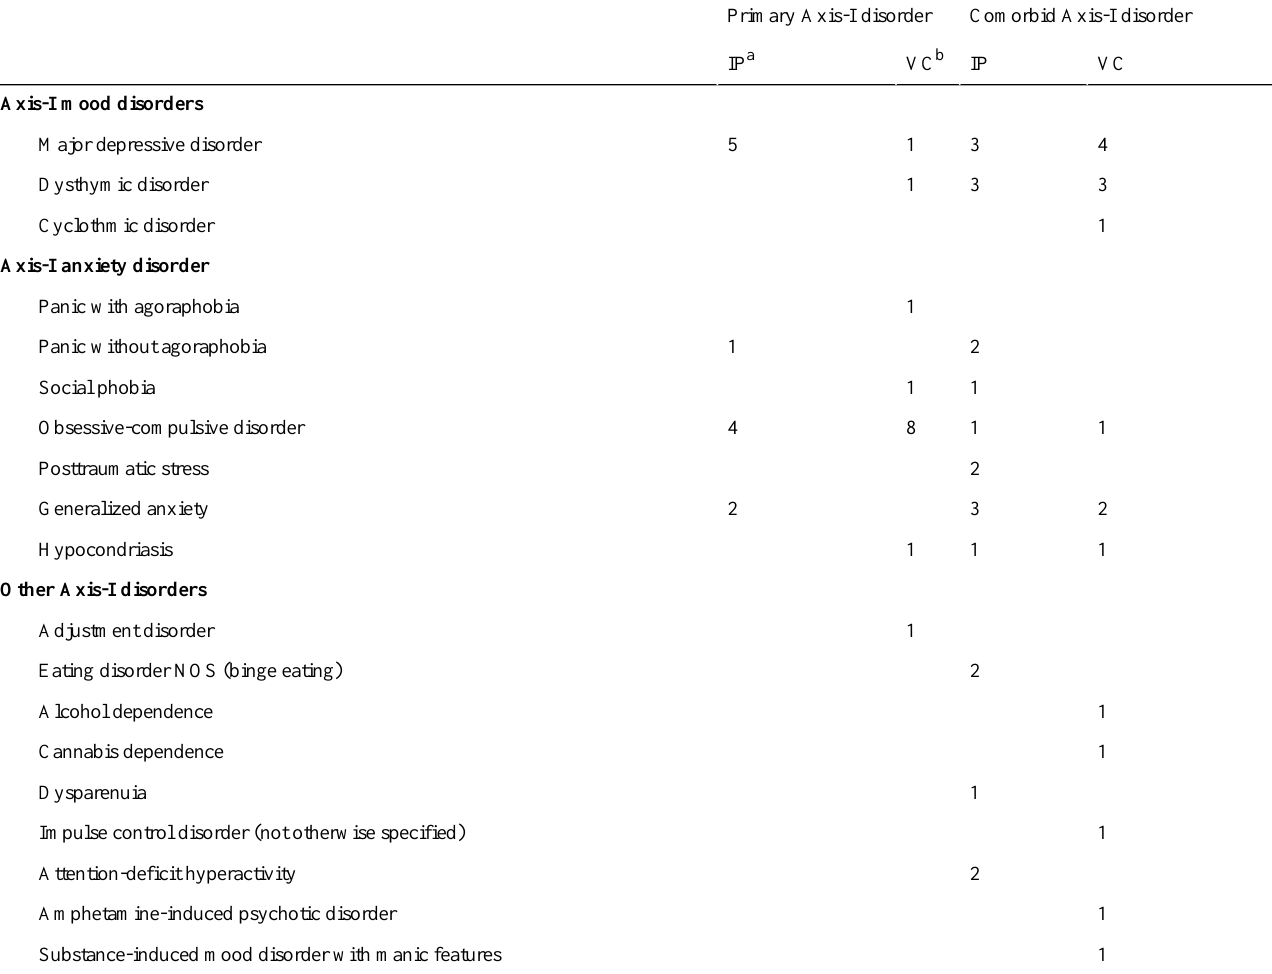
Table 1. The number of clients that met the criteria for Axis-I disorders at pretreatment.